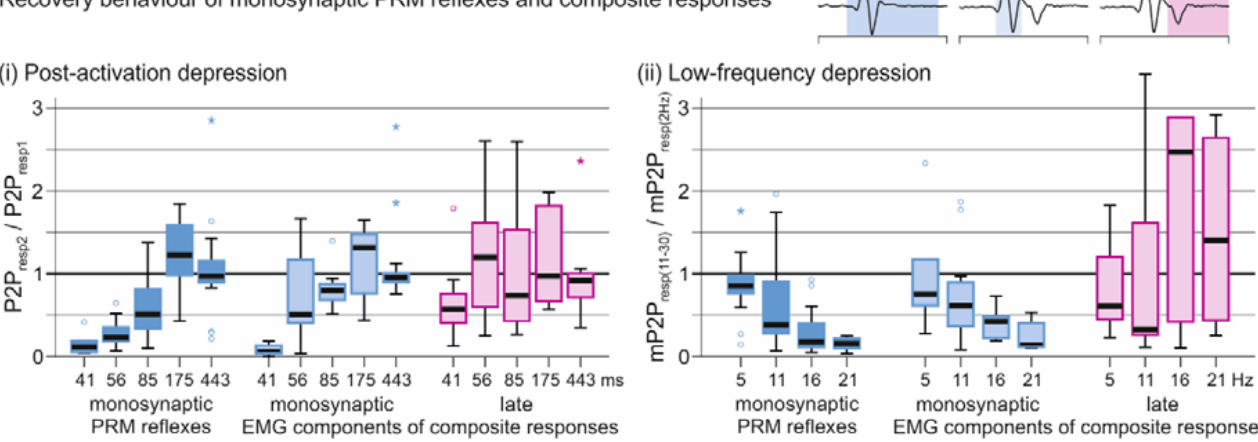
Figure 8. Recovery behavior of monosynaptic PRM reflexes and composite responses in tibialis anterior. ( i ) Post-activation depression of monosynaptic PRM reflexes as well as monosynaptic and late EMG components of composite responses tested by paired-pulses with increasing interstimulus intervals as indicated. The y-values are normalized peak-to-peak amplitudes (second, resp2, to first response, resp1) per interstimulus interval. ( ii ) Low-frequency depression of the respective response types tested by trains of EES with increasing stimulation frequency as indicated. The y-values are normalized mean peak-to-peak amplitudes (mean of 11th to 30th responses, resp(11–30), to mean of responses to 2 Hz, resp(2Hz)). Circles illustrate outliers and asterisks extreme values. Data derived from subjects 3, 6, 7, and 8 (one recording each); numbers of available data sets per frequency: 17–39. EES, epidural electrical stimulation; m, mean; P2P, peak-to-peak EMG amplitude; PRM, posterior root ‐ muscle.